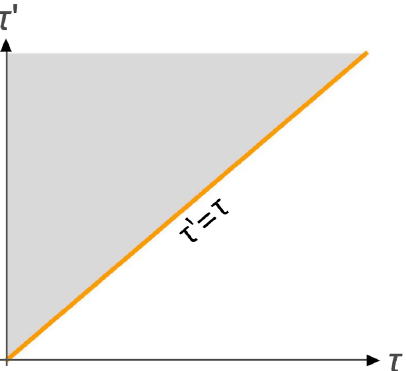
FIG. 7. Region of integration for Eq. (A16). The shaded area corresponds to the region of integration in the τ − τ 0 plane, for the expression on the right-hand side of Eq.